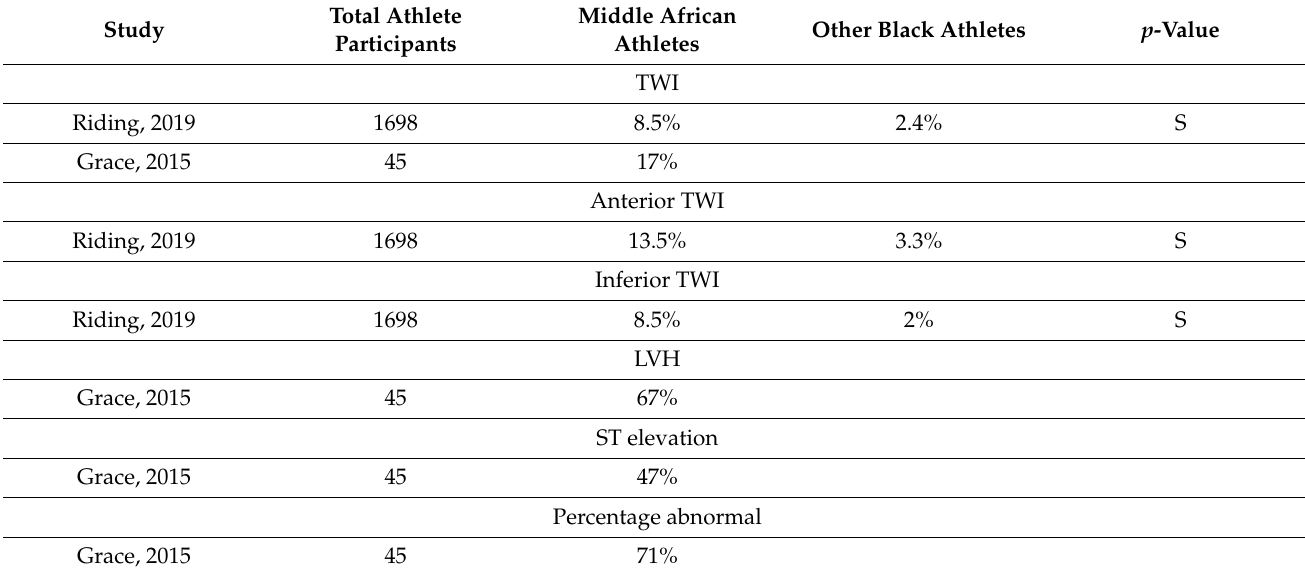
Abbreviations: TWI, T-wave inversion; LVH, left-ventricular hypertrophy; S, significant. Mixed-Race Athletes Mixed-race athletes (defined as athletes with Black and Caucasian parents [28]) were only assessed in two papers. Malhotra et al. (2021) found that mixed-race athletes were more closely associated with Black athletes than Caucasian athletes [28], as detailed in Table 5. TWI was more common in Black athletes than mixed athletes but far less common in Caucasian athletes (12.6%, 8.6%, and 2.3% respectively). Mixed-race athletes were similar to Black athletes in inferior TWI (2% vs. 1.5%; p = 0.49) and lateral/apical TWI (0.6% vs. 1%; p = 0.33). The other paper had small numbers of athletes that were not the focus of assessment